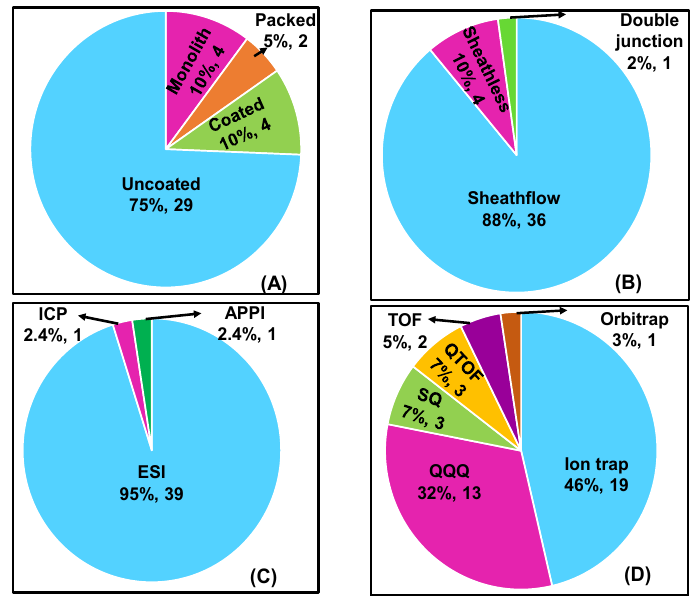
Figure 5. Pie charts showing the distribution of various ( A ) column types, ( B ) interfaces, ( C ) ionization sources, and ( D ) mass analyzers used in chiral CE-MS over the period